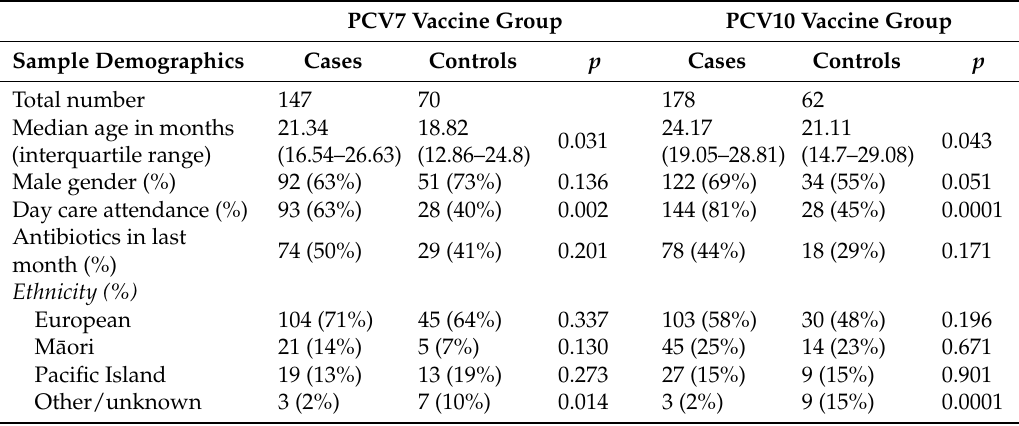
Table 2. Demographics of study cohort and comparison between cases and controls within PCV7- and PCV10-vaccinated